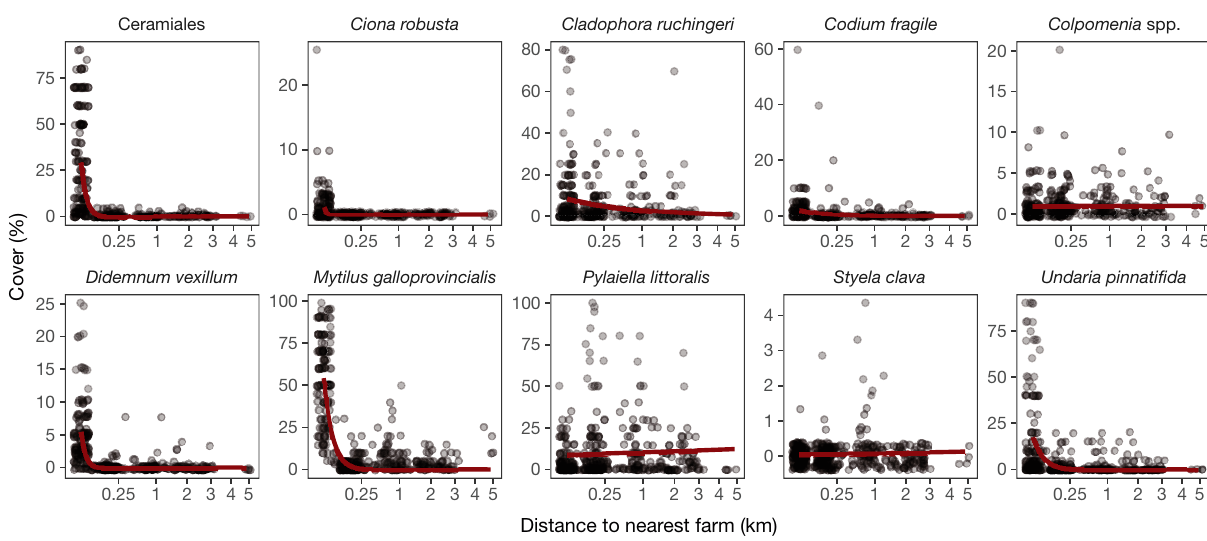
Fig. 5. Exponential decay curves showing predicted reduction in cover of the 10 focal taxa in relation to distance to the nearest mussel farm (km). Note that x -axes are in square root scale and y -axis scale varies between